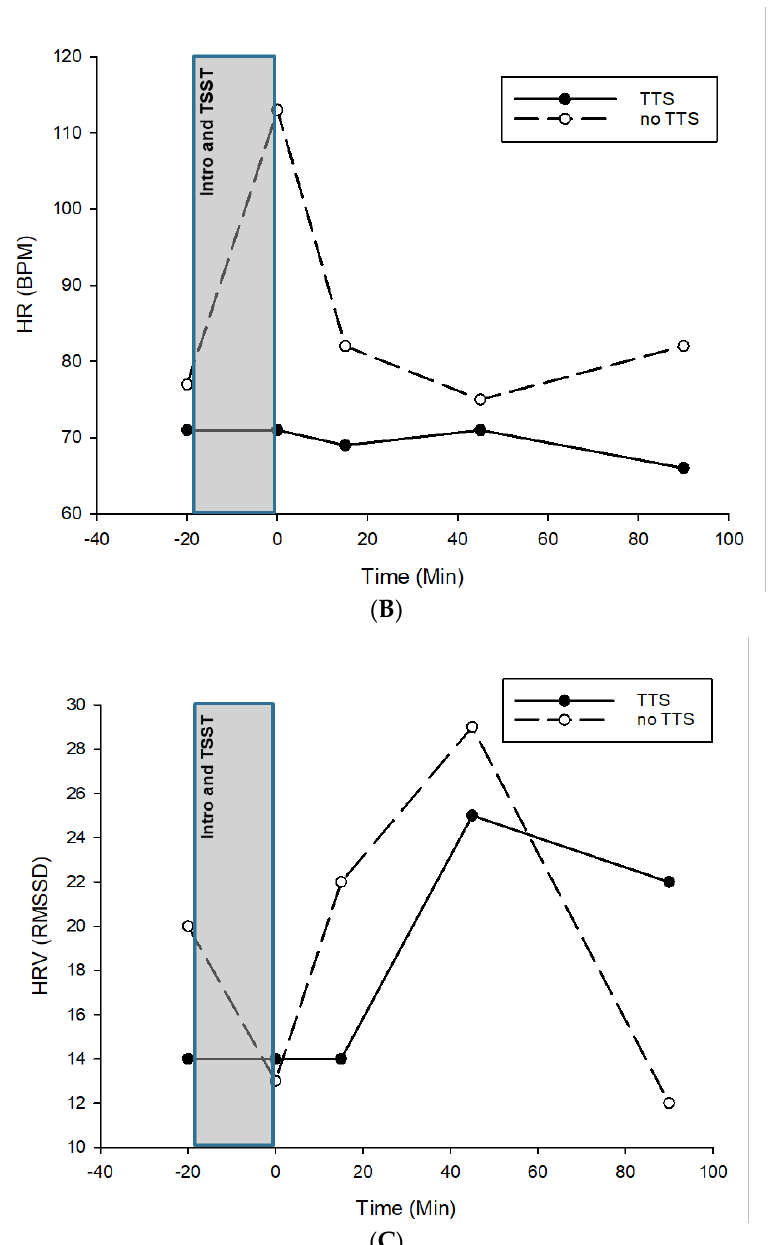
Figure 1. ( A ) Systolic blood pressure reactivity to TSST in TTS and non − TTS twin. Note: SBP = systolic blood pressure, DBP = diastolic blood pressure, TSST = Trier Social Stress Test, TTS = twin with Takotsubo syndrome, no TTS = twin with no Takotsubo syndrome. ( B ) Heart Rate reactivity to TSST in TTS and non-TTS twin. Note: HR = heart rate, BPM = beats per minute, TSST = Trier Social Stress Test, TTS = twin with Takotsubo syndrome, no TTS = twin no Takotsubo syndrome. ( C ) Heart Rate Variability reactivity to TSST in TTS and non-TTS twin. Note: HRV = heart rate variability, TSST = Trier Social Stress Test, TTS = twin with Takotsubo syndrome, no TTS = twin with no Takotsubo syndrome.